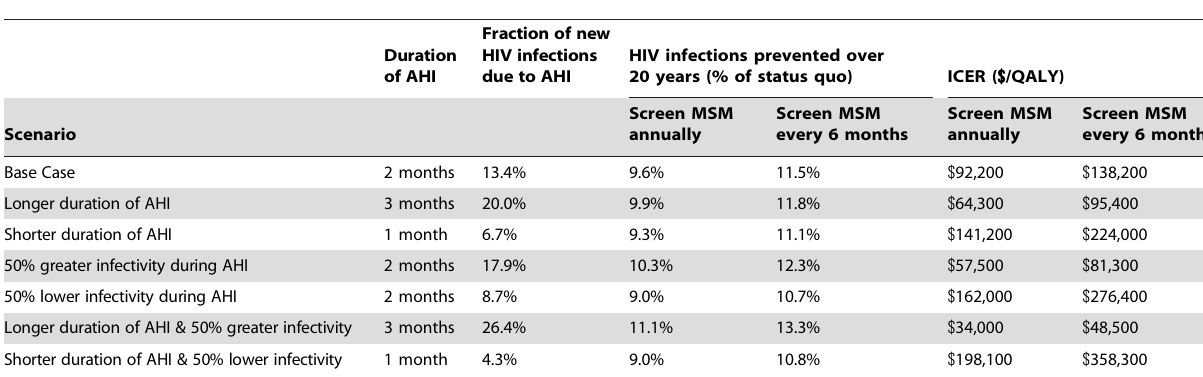
Table 4. Sensitivity analysis on the impact of acute HIV